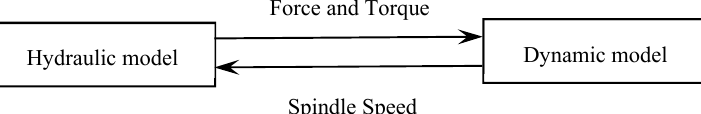
Figure 4. Data exchange.